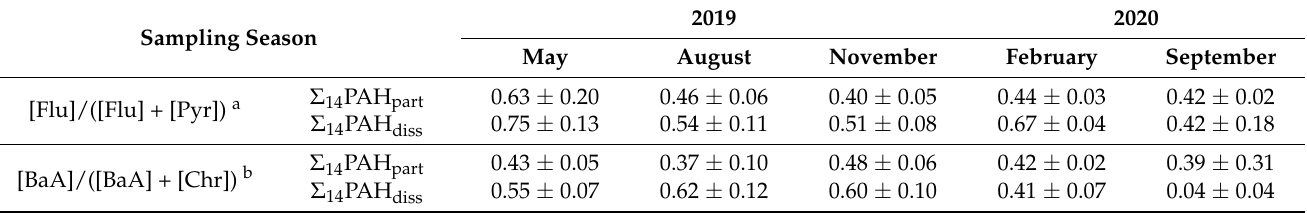
Table 2. Diagnostic isomer ratio averages ( ± standard deviation) at each sample season, for particulate and dissolved PAHs. Sampling Season